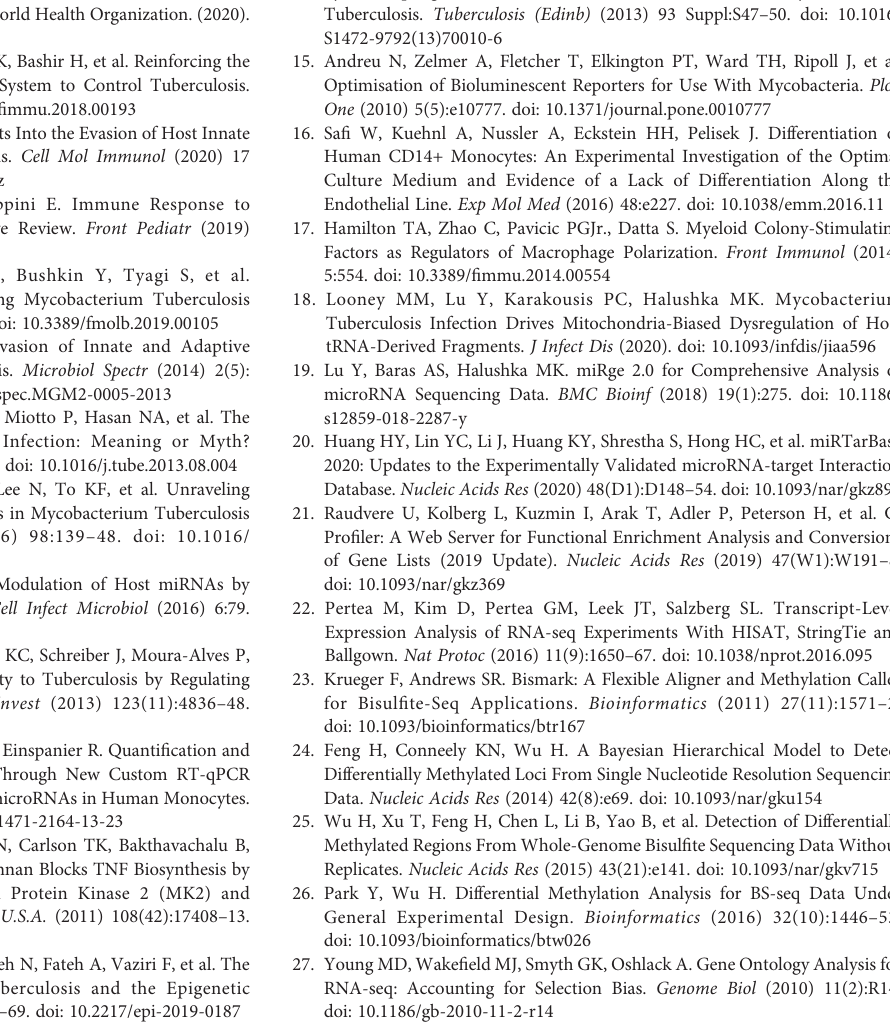
Supplementary Table 3 | Functional enrichment analysis of differentially expressed mRNAs. See attached Supplemental_Table_3_DEmiRs.csv fi le fi le. Supplementary Table 4 | Contingency table for enrichment of dysregulated miRNA targets. Chi-square analysis with Yates correction to determine if dysregulated genes are statistically enriched for miRNA targets. Total number of candidate miRNA targets was determined by miRNet (38). Total number of genes Supplementary Table 5 | Differential methylation from whole genome bisul fi te sequencing. See attached Supplemental_Table_5_DEmiRs.csv fi le fi le. Supplementary Table 6 | Contingency table for enrichment of AMPK pathway dysregulation. Chi-square analysis with Yates correction to determine if dysregulated genes (differentially methylated or expressed) are statistically enriched for AMPK pathway genes. Total number of AMPK Pathway Genes was based on KEGG pathway. Total number of genes was based on total genes detected by RNA-seq. Genes with low reads (sum across all samples less than 10 reads) were fi ltered out prior to